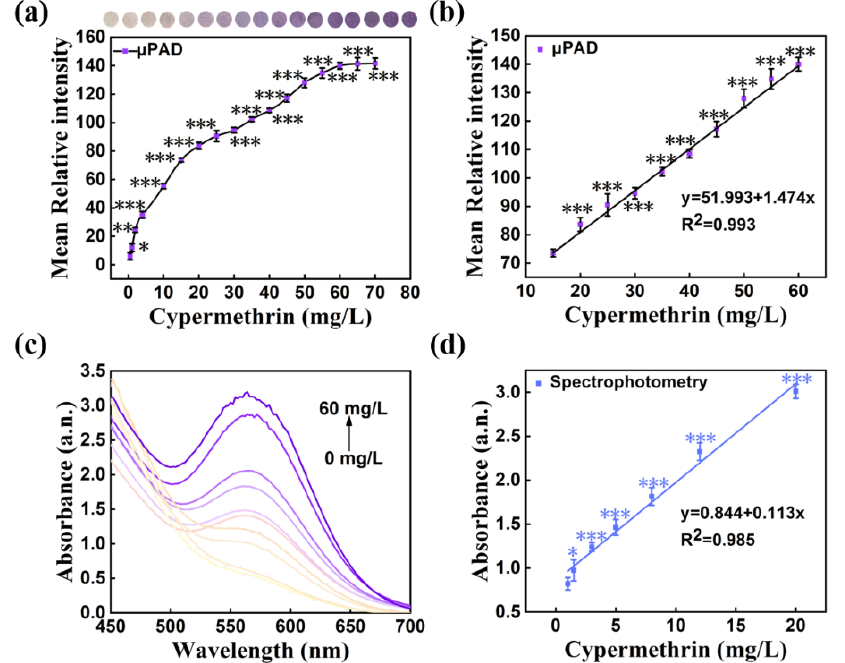
Figure 11. ( a ) The effect of different cypermethrin concentrations on the mean relative intensity of pSBMA-μPAD; ( b ) the correlation between the cypermethrin concentration and the mean relative intensity of pSBMA-μPAD; ( c ) absorbance of different cypermethrin concentrations at different wavelengths; ( d ) the cypermethrin concentration correlation between concentration and absorbance. “*” stands for significance test.